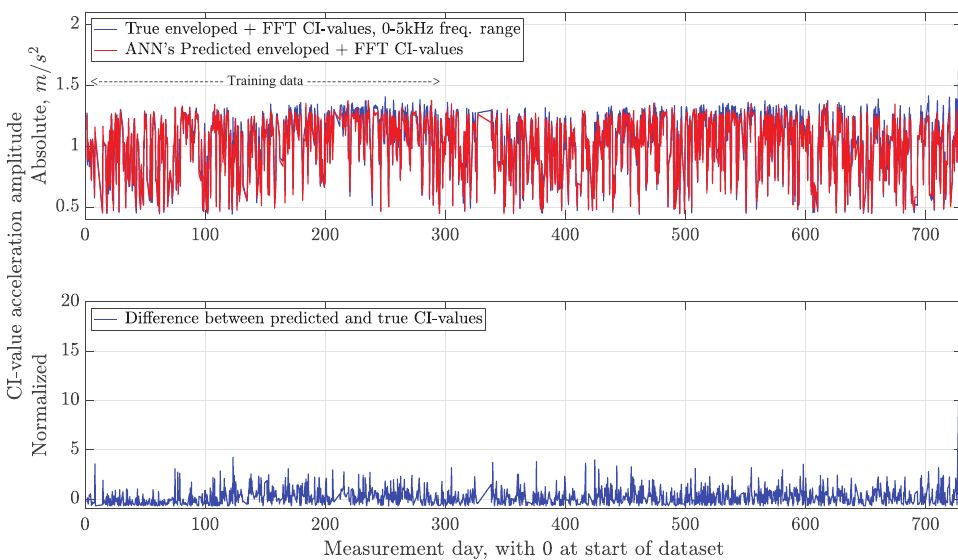
Figure 9. Gearbox output shaft bearing failure case 3, CI-values trended per day of the dataset starting at 0 from FFT spectra on enveloped measurements with a 0–5 kHz frequency range. Comparison of ANN’s predicted CI-values in red and true CI-values in blue at the top graph and normalized difference between them at the bottom